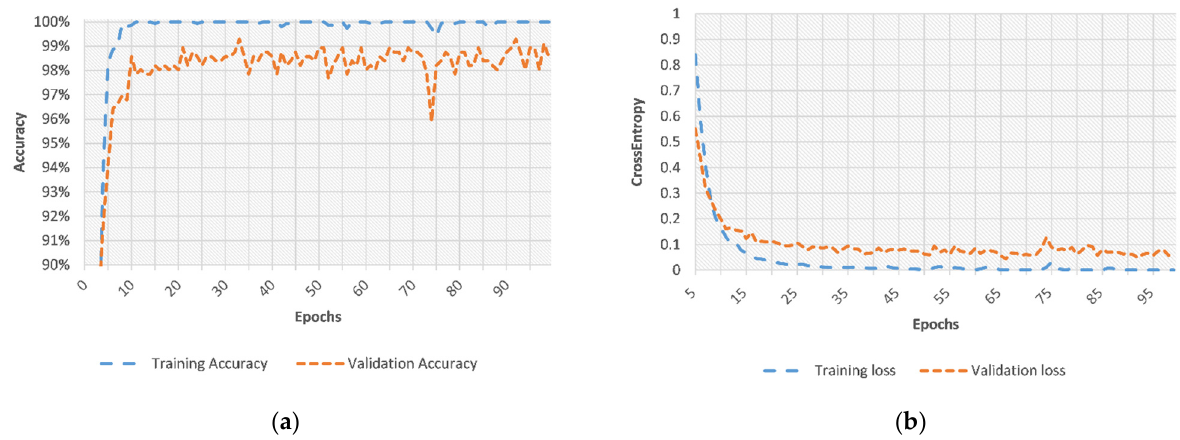
Figure 7. Performance related to the best overall configuration: ( a ) training and validation accuracy and ( b ) training and validation loss.